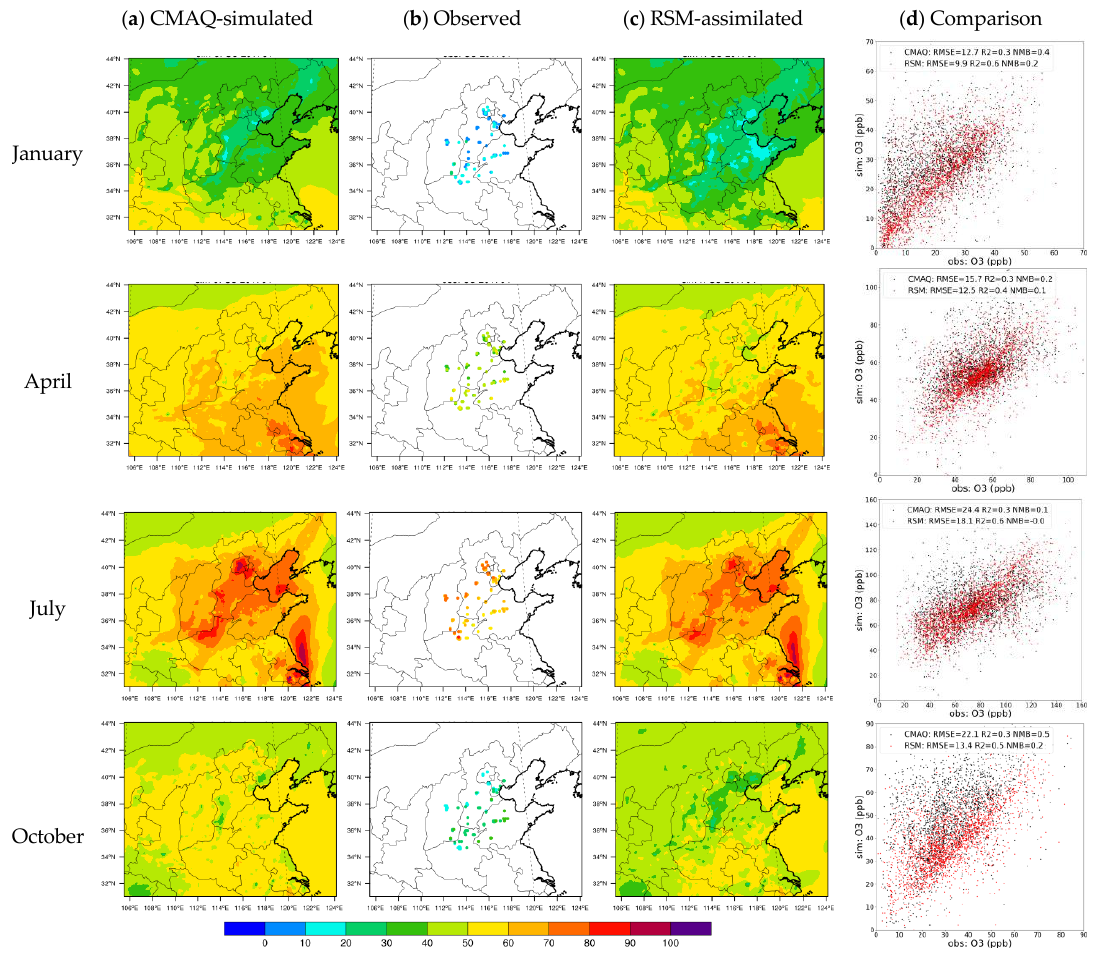
Figure 3. Comparions of CMAQ-simulated, observed, and RSM-assimilated O 3 concentrations: ( a ) CMAQ-simulation; ( b ) Observation; ( c ) RSM-assimilation; ( d ) Comparison between CMAQ- simulation or RSM-assimilation against with obervation (the comparison was done on a monthly basis for each month of comparison; unit, ppb).